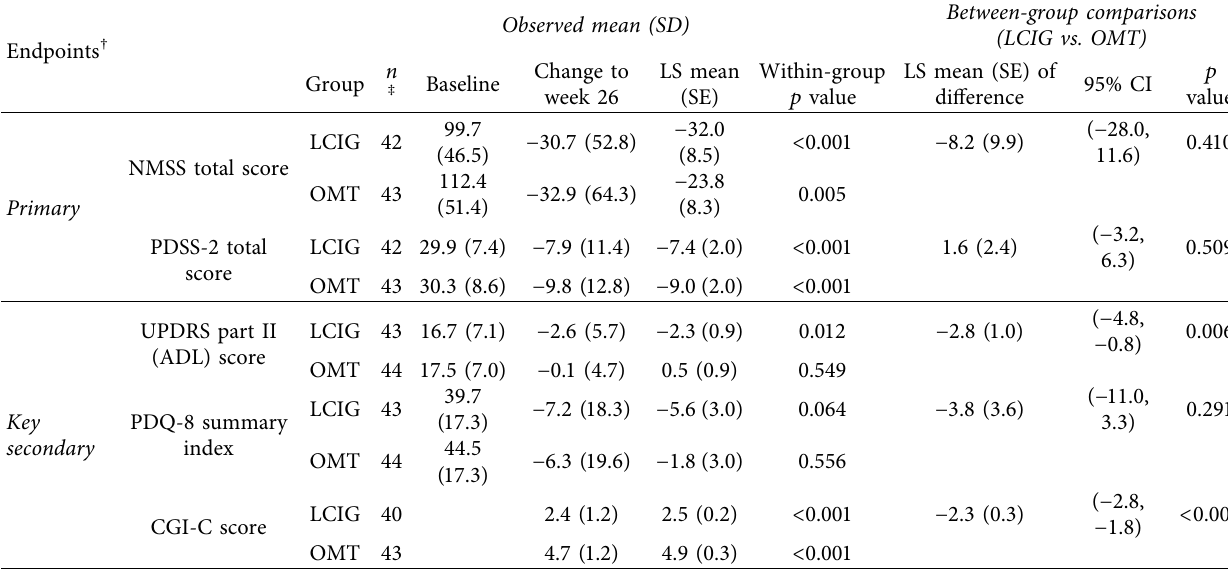
Table 2: Primary and key secondary endpoints (intent-to-treat